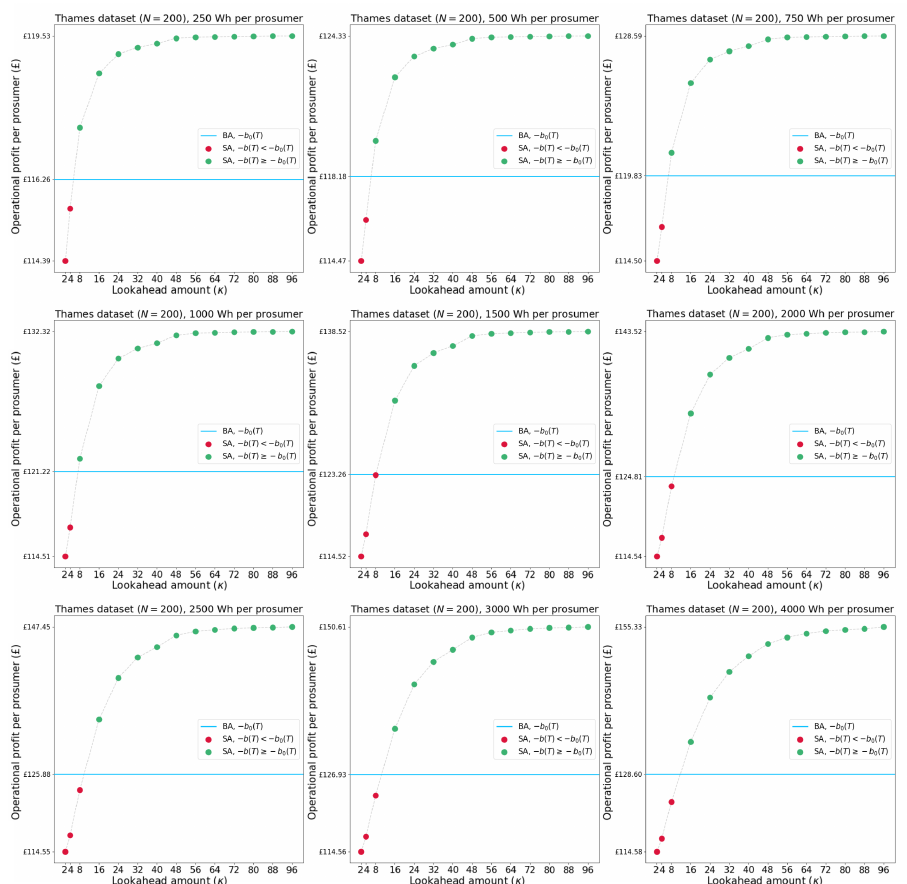
Figure A3. Part 1: Overview of operational profits per prosumer for the baseline and smart battery scheduling algorithm using various sizes for the lookahead window ( κ ) and various sizes for the battery per prosumer ( ω / N ) on original historical data of